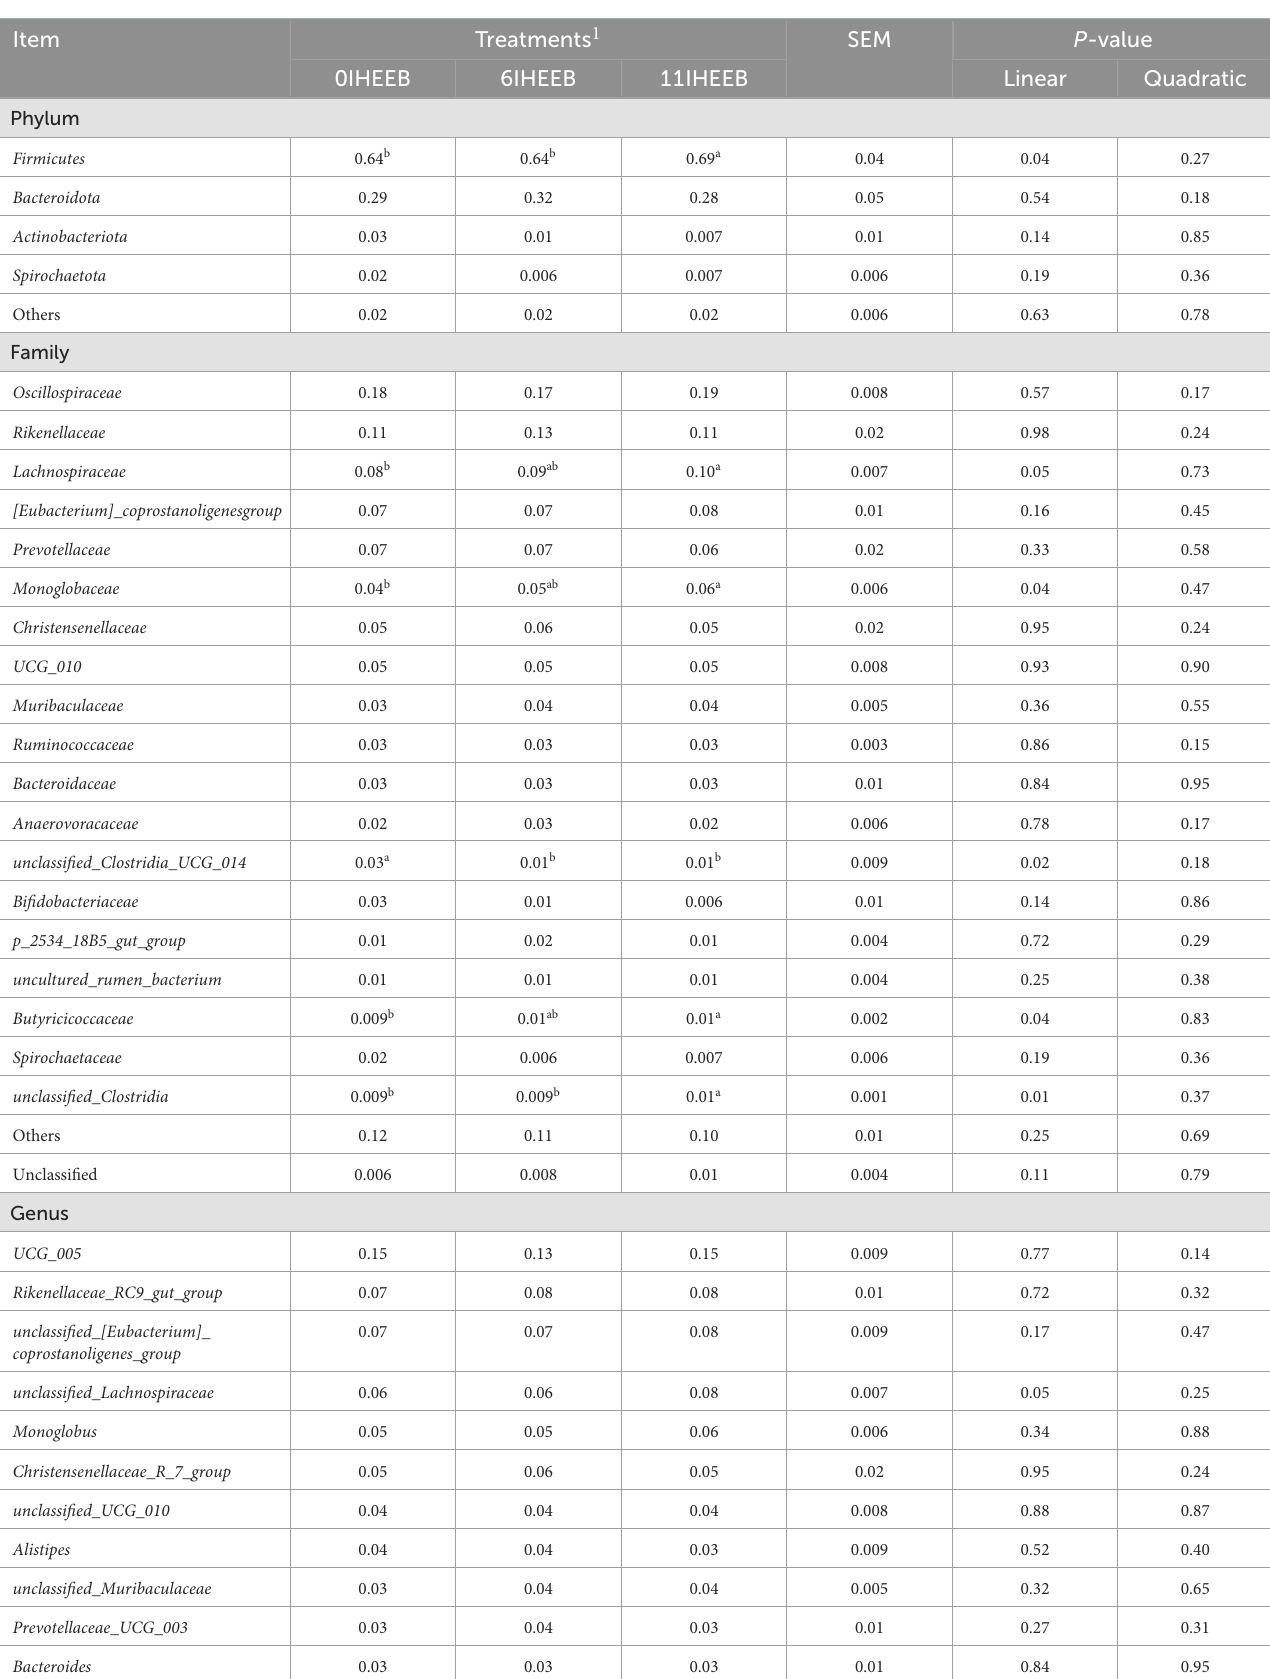
TABLE 9 Relative abundances ( > 1.0%) of the bacterial phyla, families, and genera in the feces of Holstein cows fed the 3